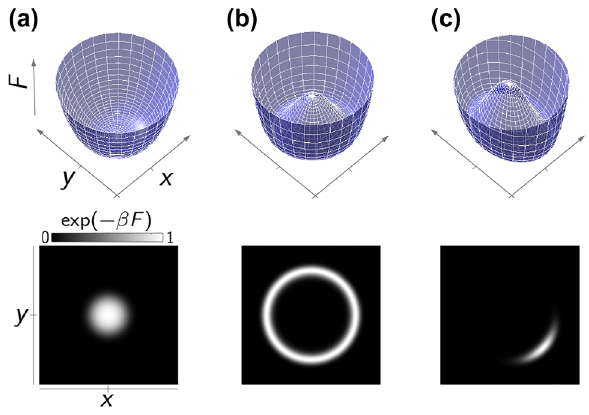
Figure 2: The Lyapunov function of a single laser (a) un-pumped, (b) pumped, (c) pumped and seeded, in the in-phase and quadrature phase √ √ 2 and y = ( a − a ∗ ) ∕ 2 i coordinates, x = ( a + a ∗ ) ∕